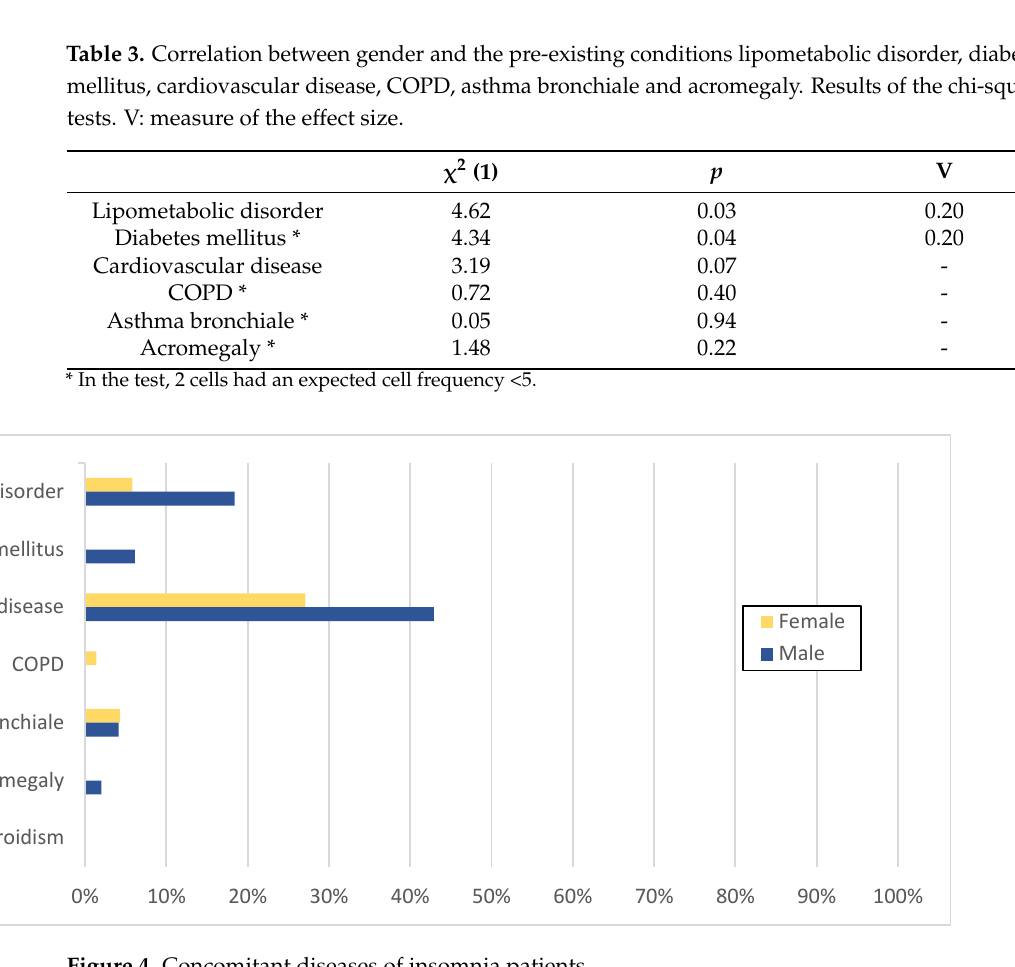
Figure 4. Concomitant diseases of insomnia patients.